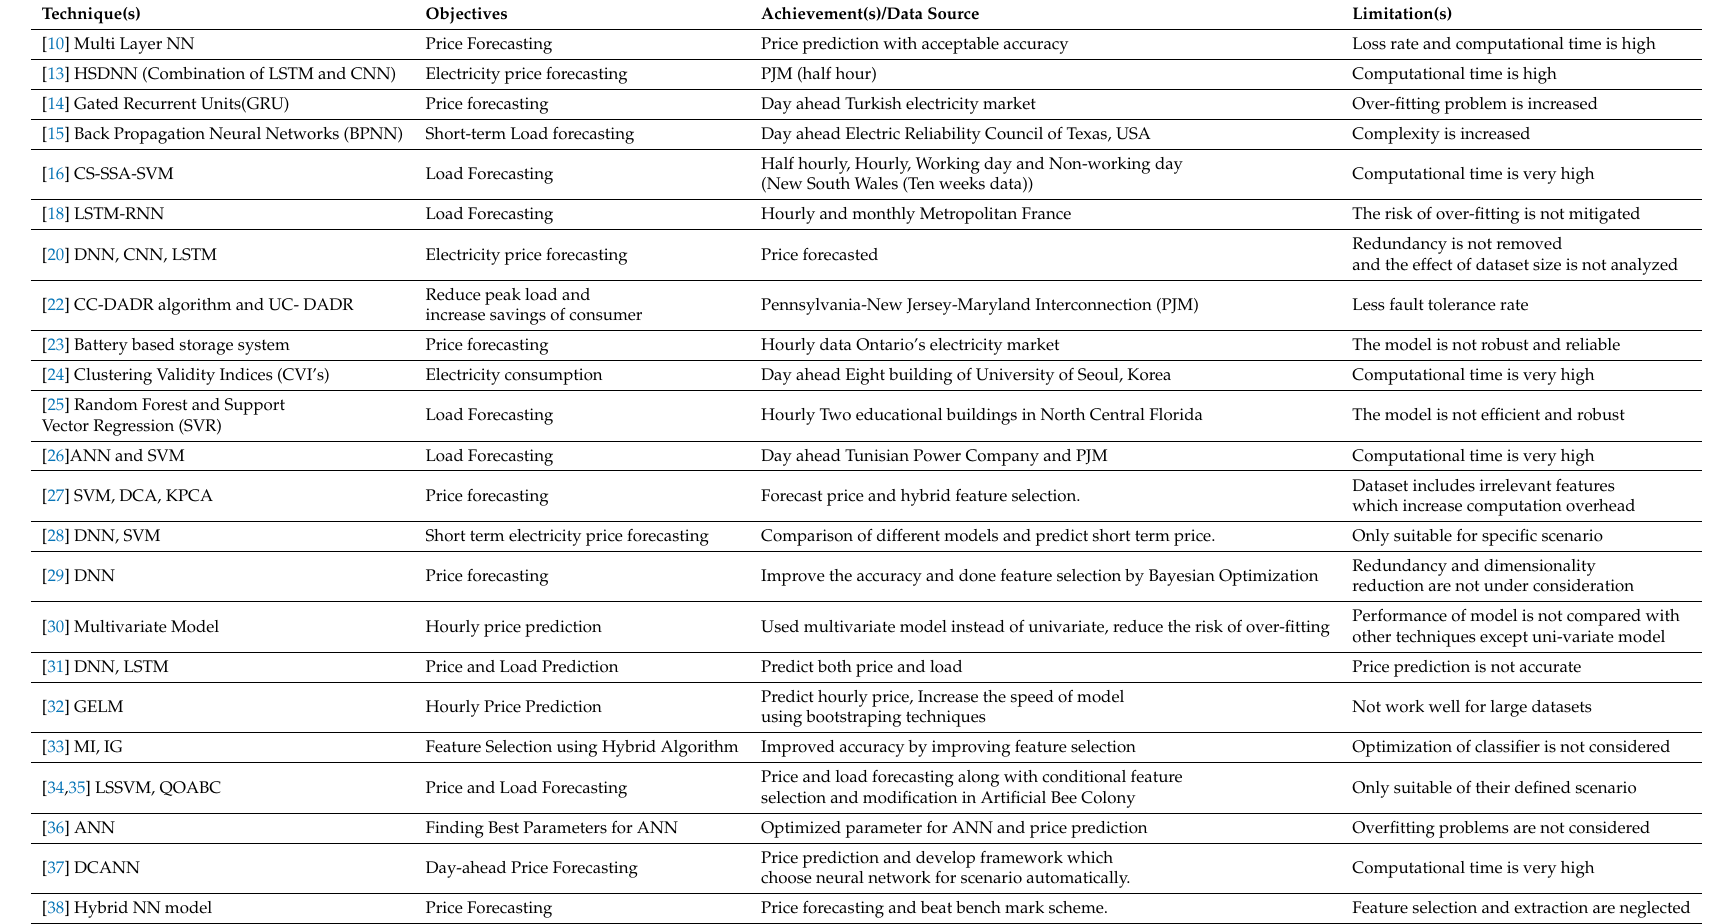
Table 1. Summary of Related